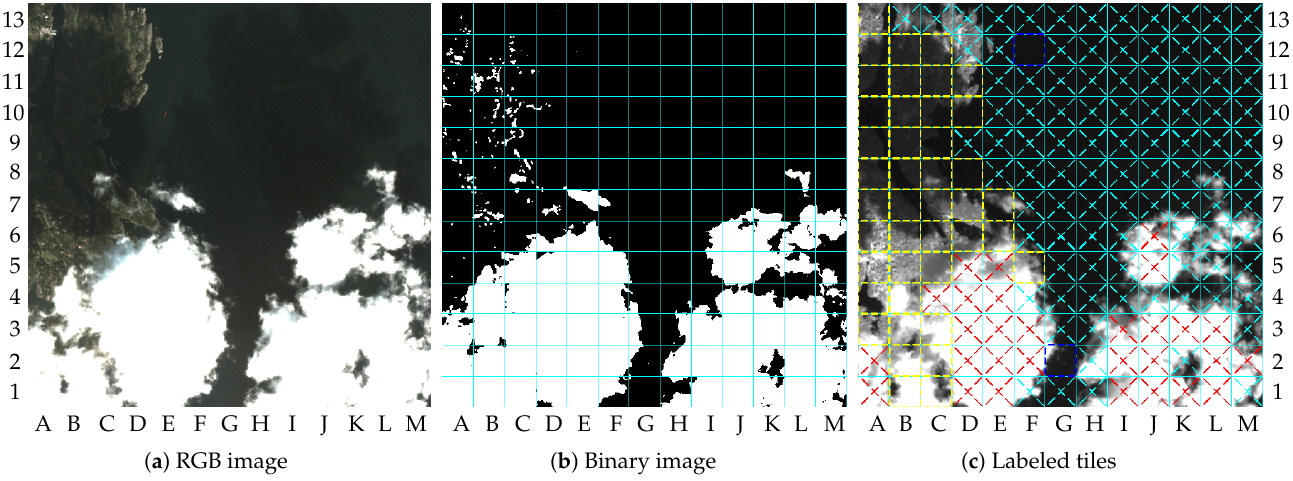
Figure 13. Results for image 10: ( a ) RGB image (truncated at 2000); ( b ) binary image; ( c ) labeled tiles (truncated at 4000).